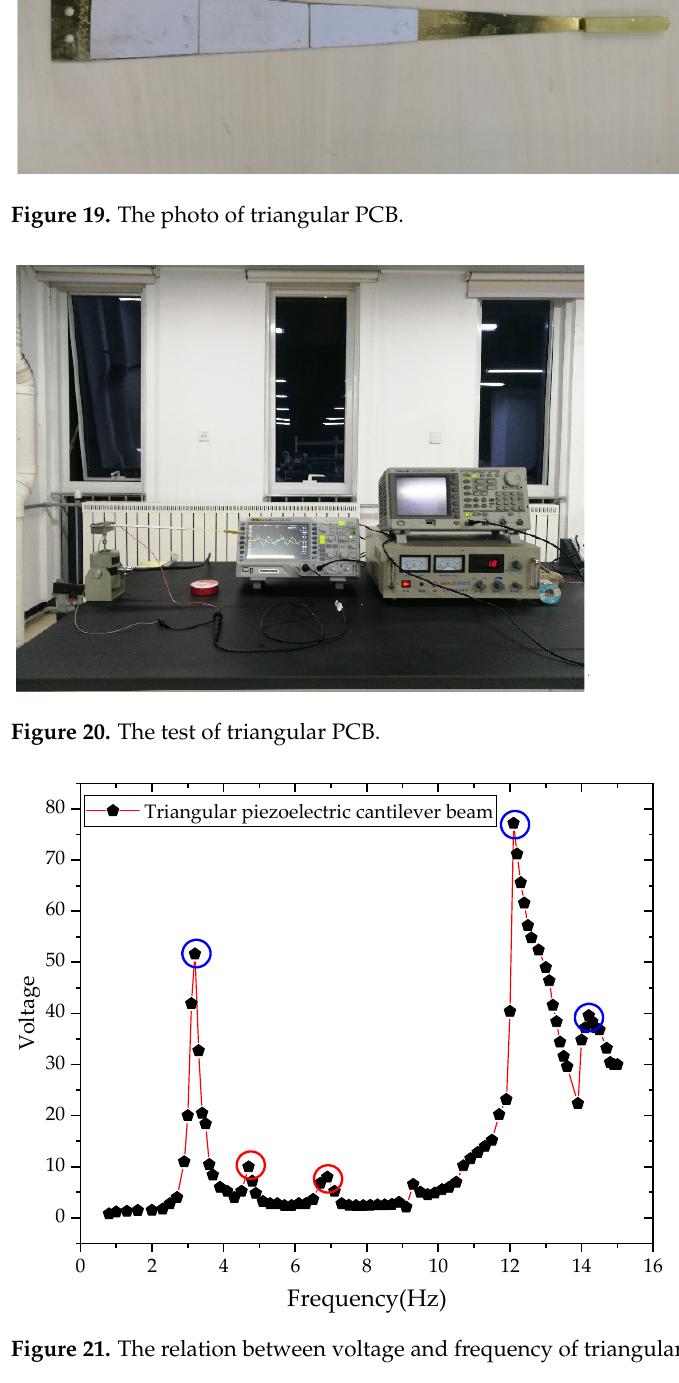
Figure 19. The photo of triangular PCB.